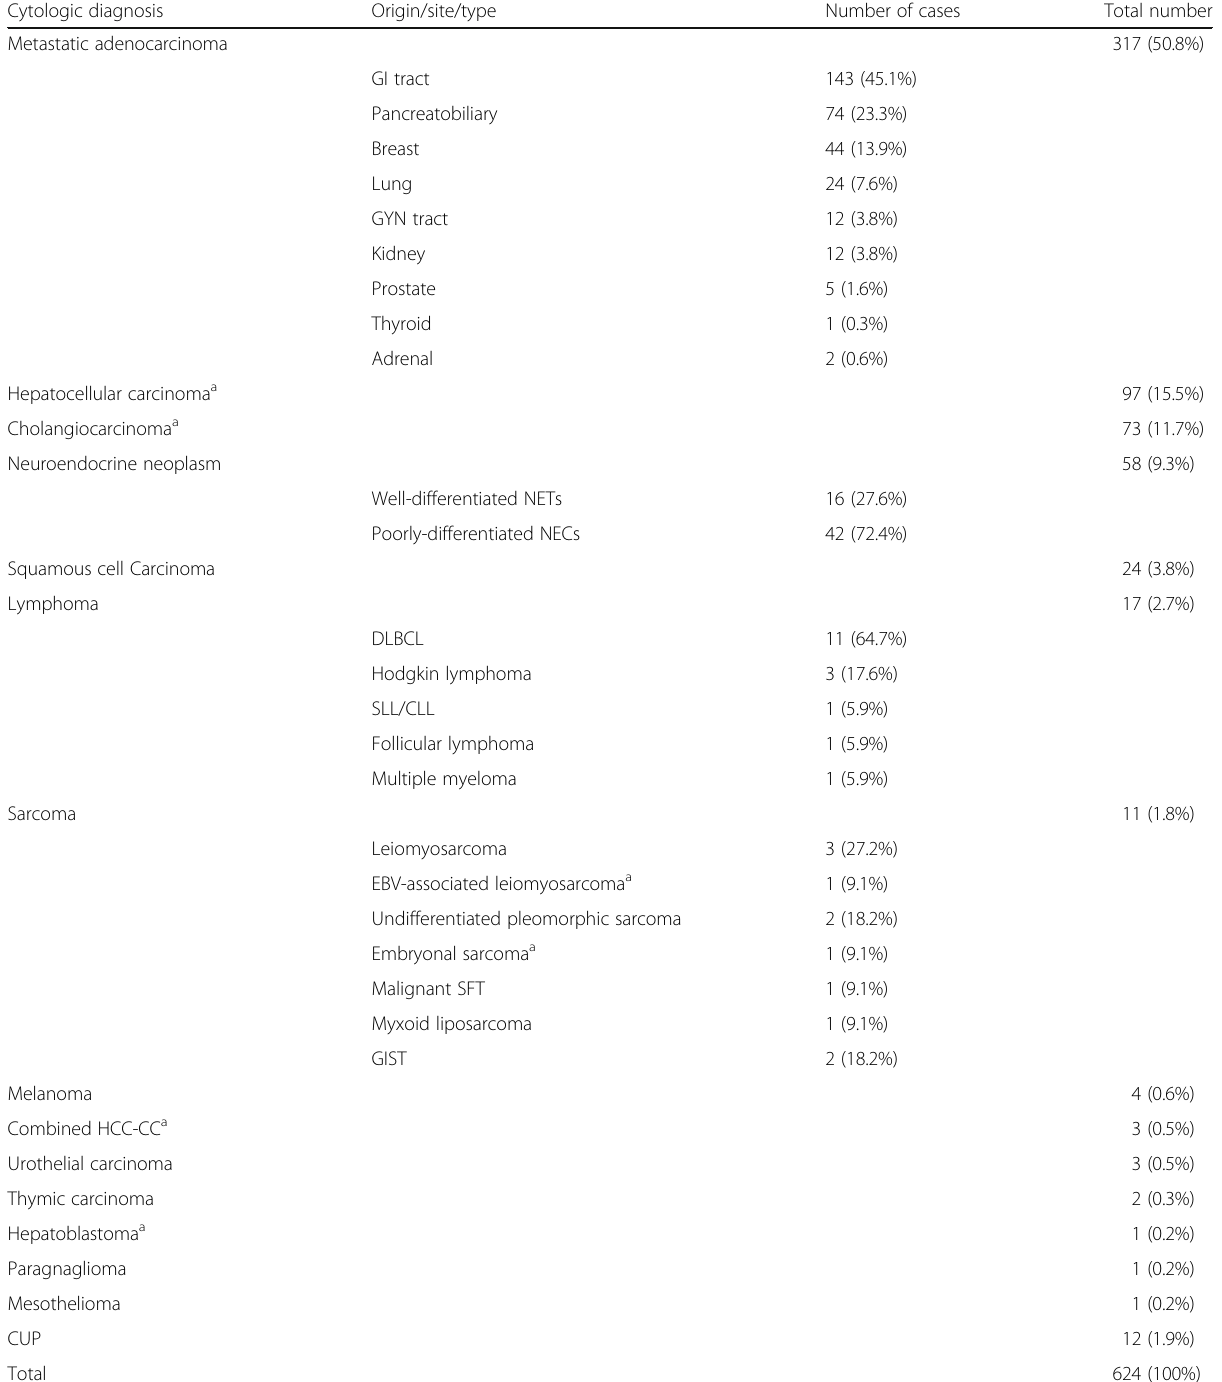
Table 1 Malignant neoplasms of 624 liver lesions diagnosed by FNB Cytologic